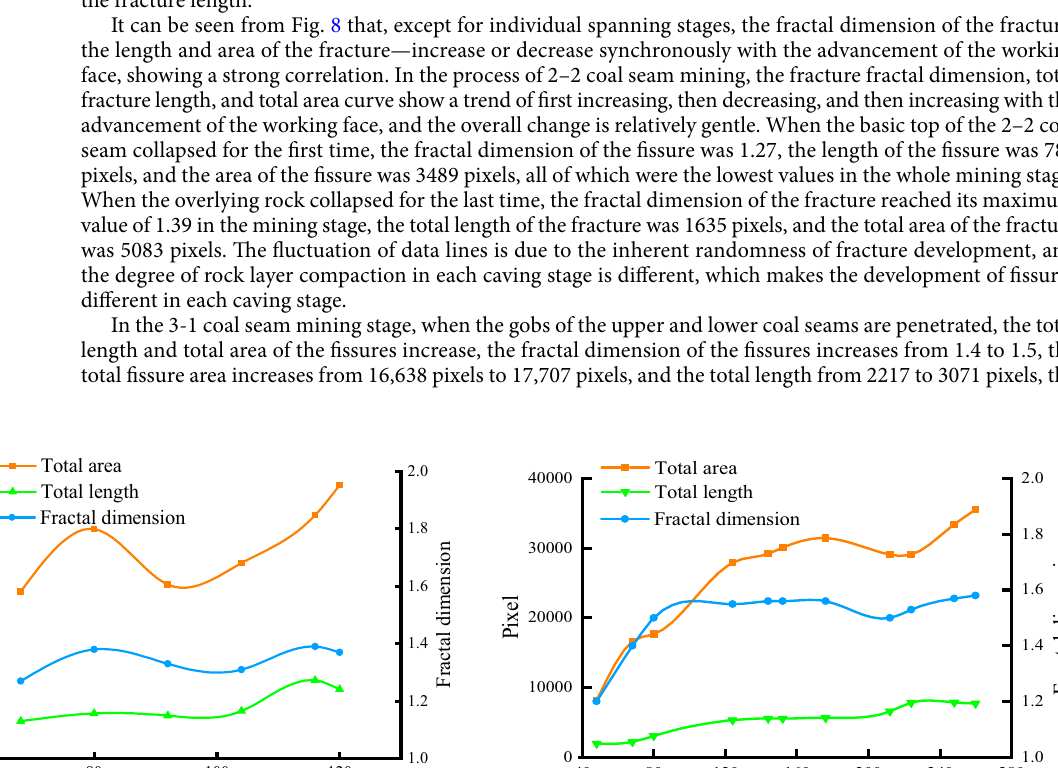
Figure 8. Calculation results of fracture fractal